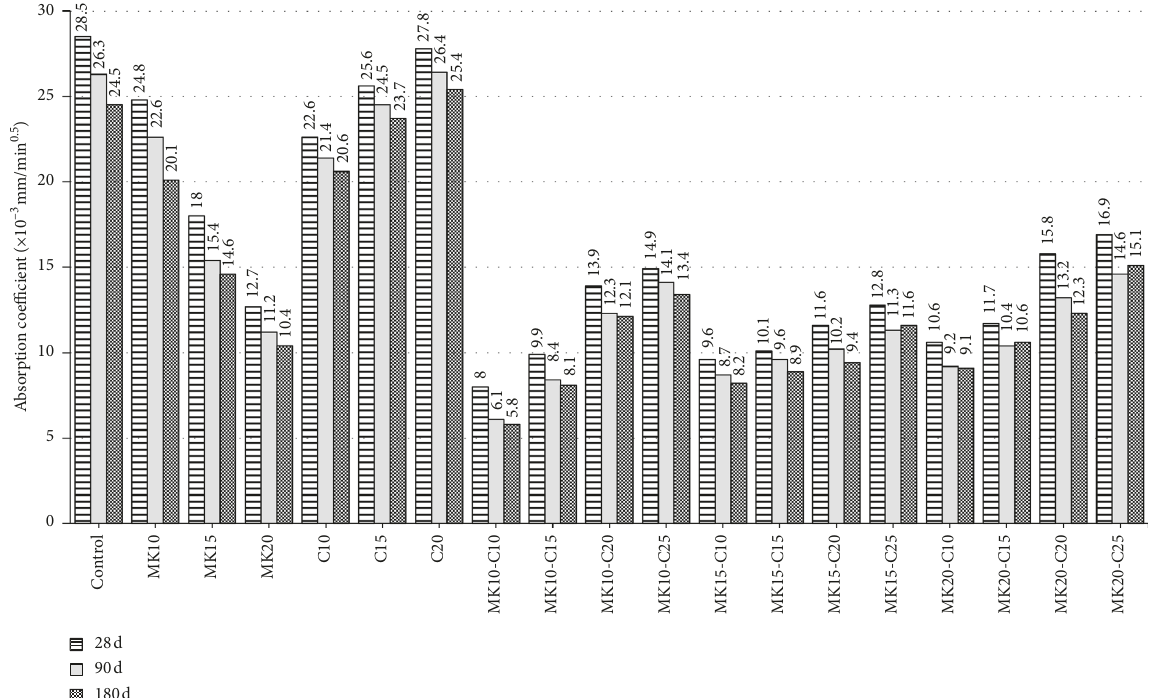
Figure 5: Capillary absorption coefficient for all